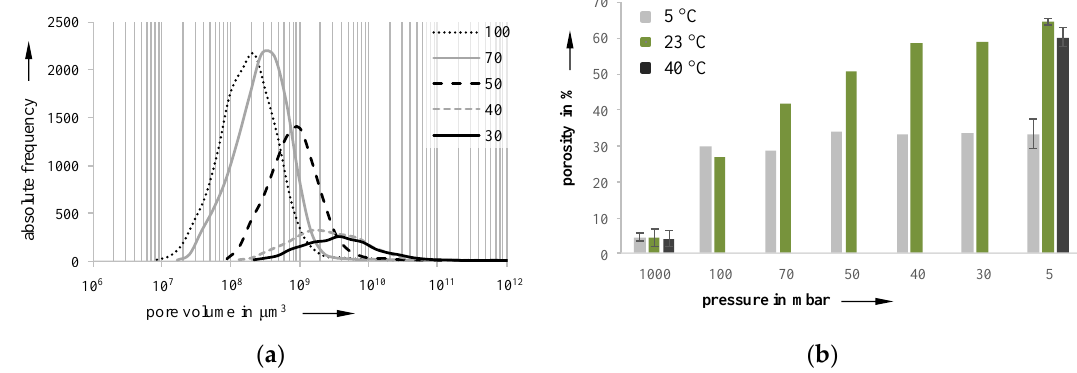
Figure 9. Pore size distribution of a 23 °C sample ( a ) and porosity ( b ) at 5, 23, and 40 °C samples of different holding stages; pressure reduction rate: 10 mbar/s.